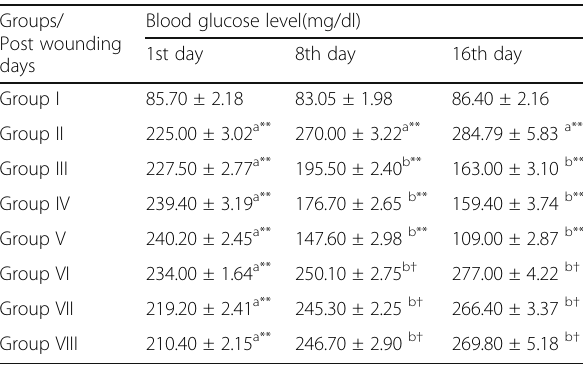
Table 4 Effect of ethanolic extracts of E. hirta on the fasting plasma blood glucose level of experimental rats Groups/ Post